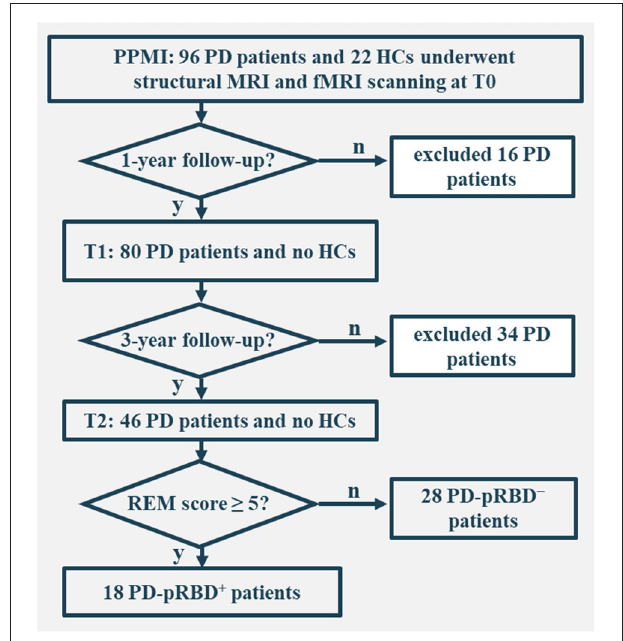
FIGURE 1 | Flowchart of data inclusion. T0, fMRI data at onset; T1, the 1-year follow-up evaluation; T2, the 3-year follow-up evaluation; PD-pRBD + , Parkinson’s disease (PD) with probable rapid eye movement (REM) sleep behavior disorder (pRBD); PD-pRBD − , PD without pRBD; HC, healthy control.